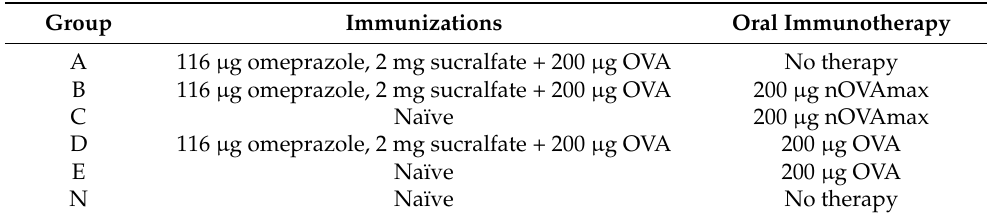
Table 1. Immunization protocol and oral immunotherapy. Overview of the substances used for immunization and/or therapy. Abbreviations used: nOVAmax—maximally nitrated ovalbumin;